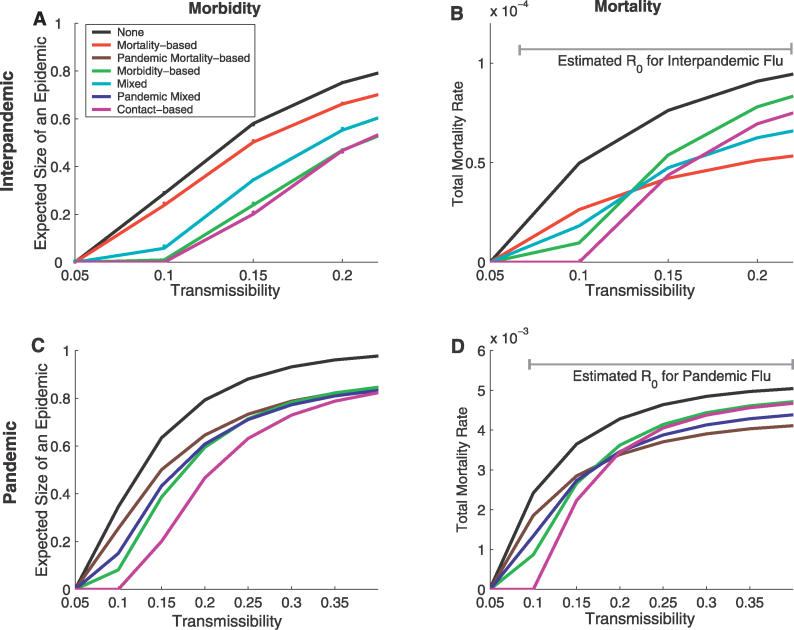
Morbidity and Mortality for Influenza Epidemics and PandemicsExpected (A) attack rate and (B) mortality rate as a function of T for annual influenza epidemics.Expected (C) attack rate and (D) mortality rate as a function of T for an influenza pandemic.The dots in (A) show simulation results for comparison. Estimates of R
0 for interpandemic and pandemic flu are shown as gray lines in (B) and (D), respectively.